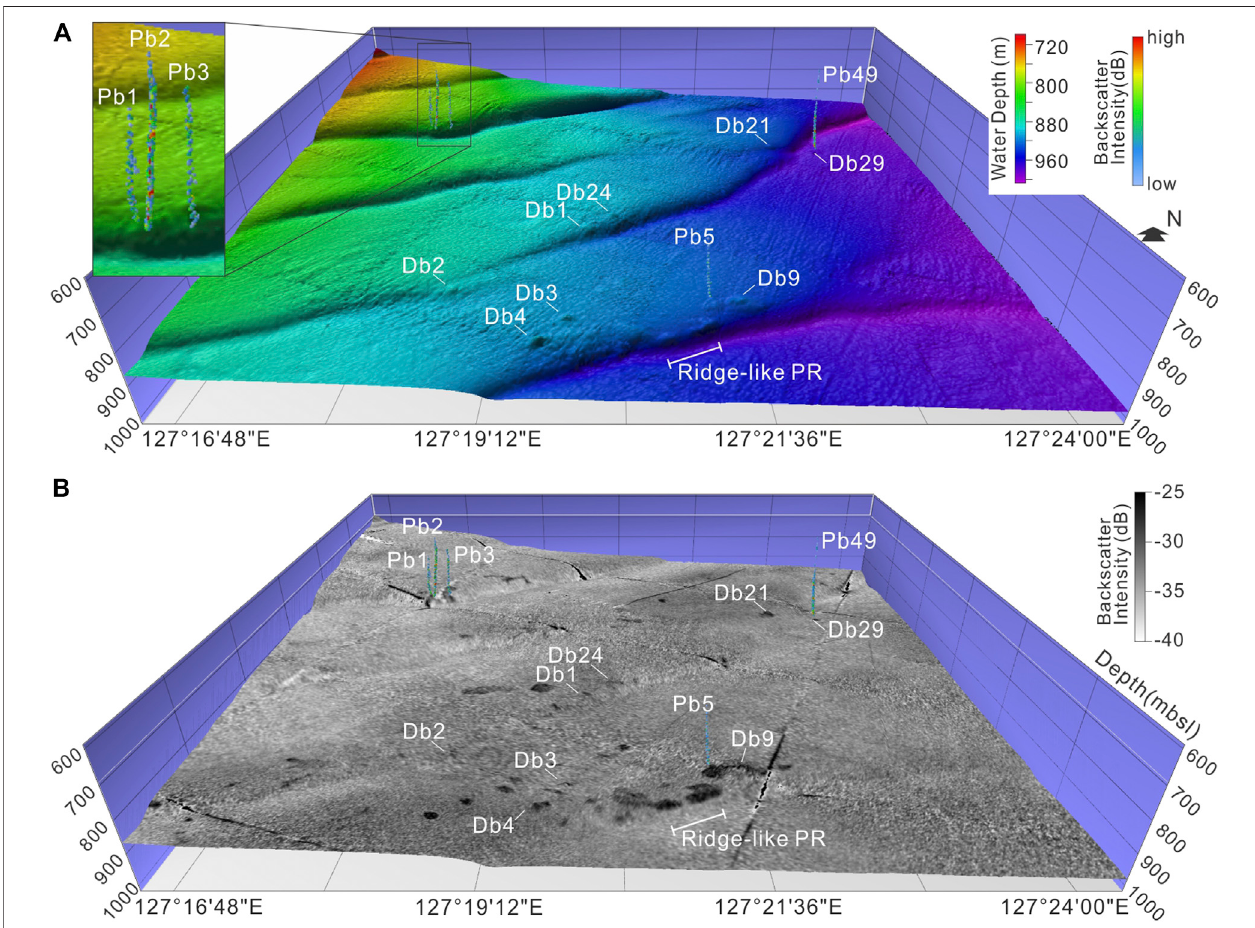
FIGURE 6 | (A) 3-D view of the bathymetry showing the geometries of the positive reliefs and the gas plumes. (B) 3-D view of the map of the backscattering intensities superimposed on the bathymetric one.